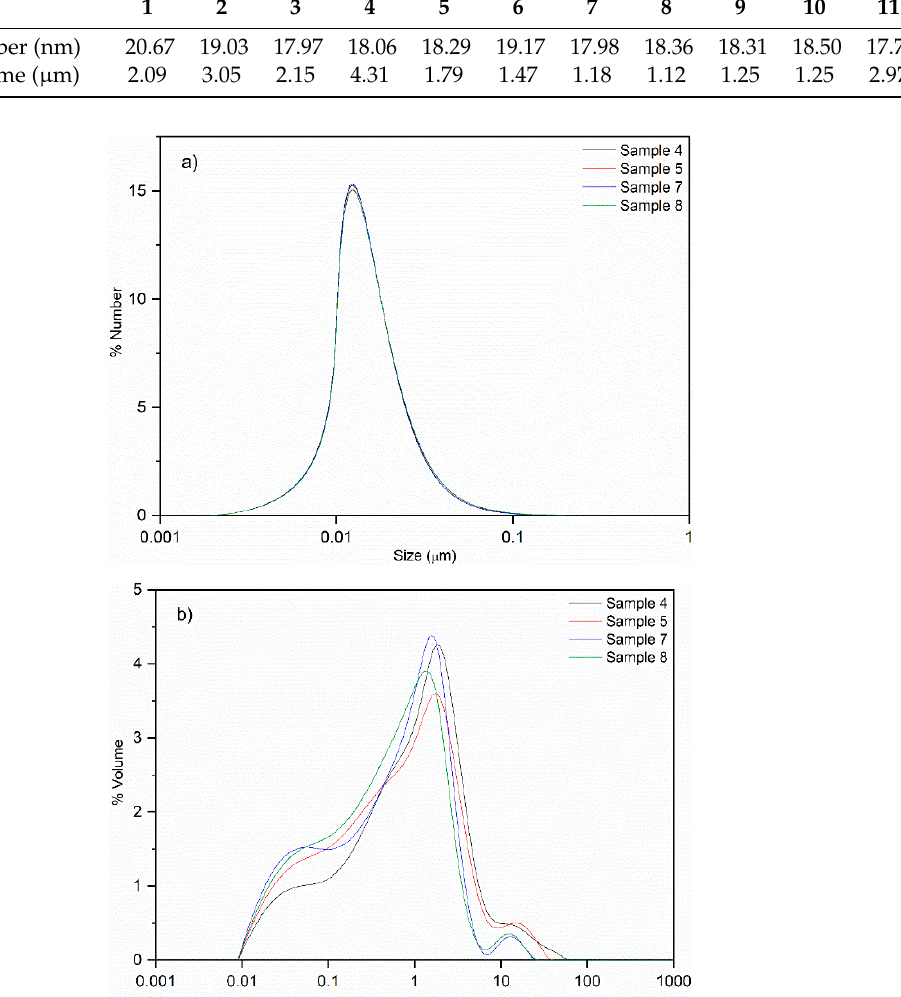
Figure 4. Particle size distribution of samples using an O / W ratio of 10 / 90 (4, 5, 7, and 8) in ( a ) number or ( b ) volume.